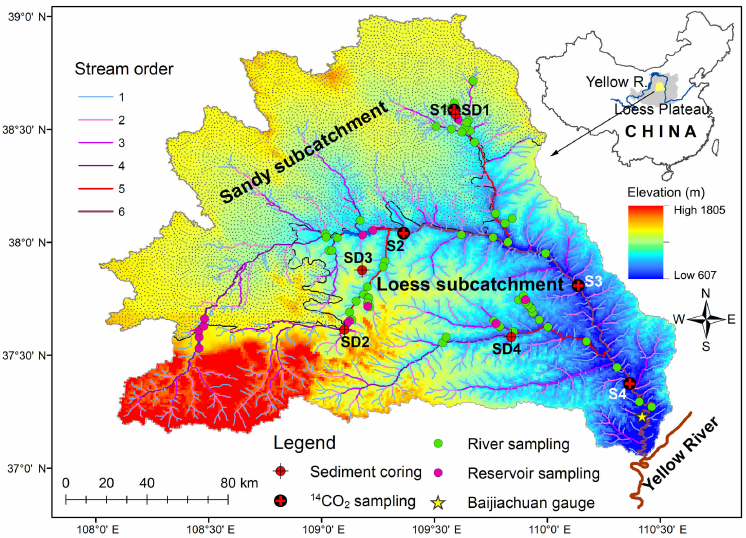
Figure 1. Map of the Wuding River catchment showing the sampling sites. SD1–SD4 and S1–S4 denote the sampling locations of sediment coring behind check dams and carbon isotope sites, respectively. The inset map shows its location on the Loess